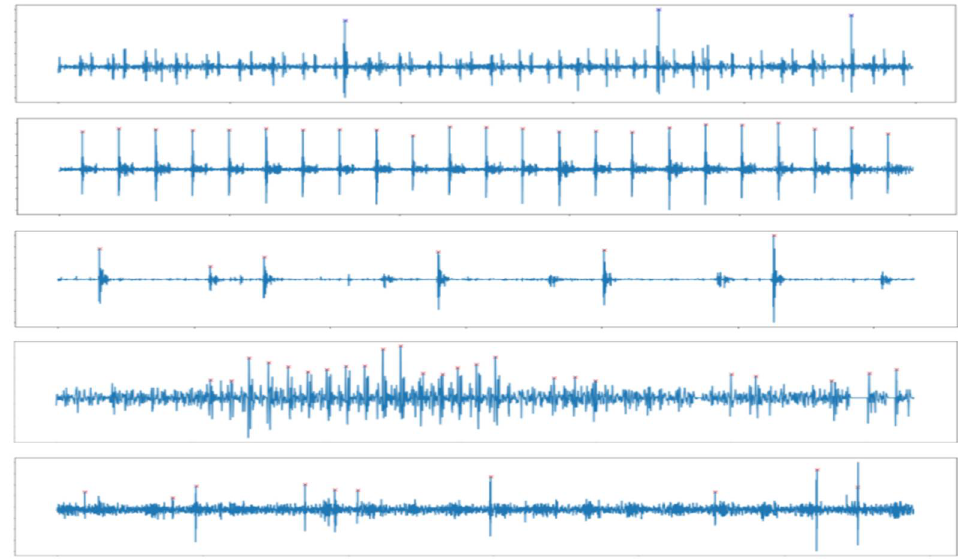
Figure 4. Examples of not detecting S1 and S2 using the time difference method.